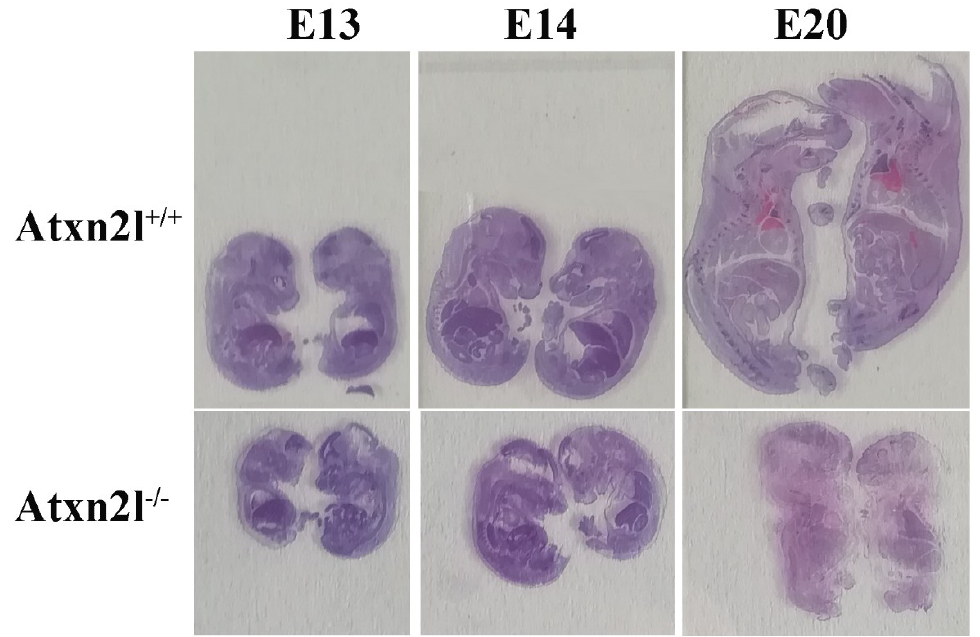
Figure 4. Evident growth/weight phenotype: Atxn2l +/+ embryos with Atxn2l −/− littermates (WT above, homozygote mutants below, E13 on left side, E14 in center, E20 on right side).